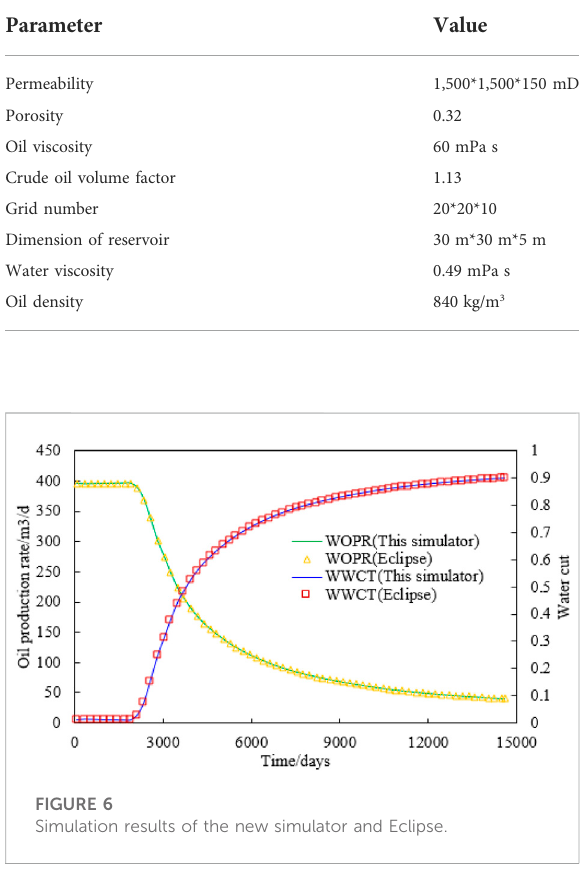
TABLE 1 Basic parameters of the conceptual model.